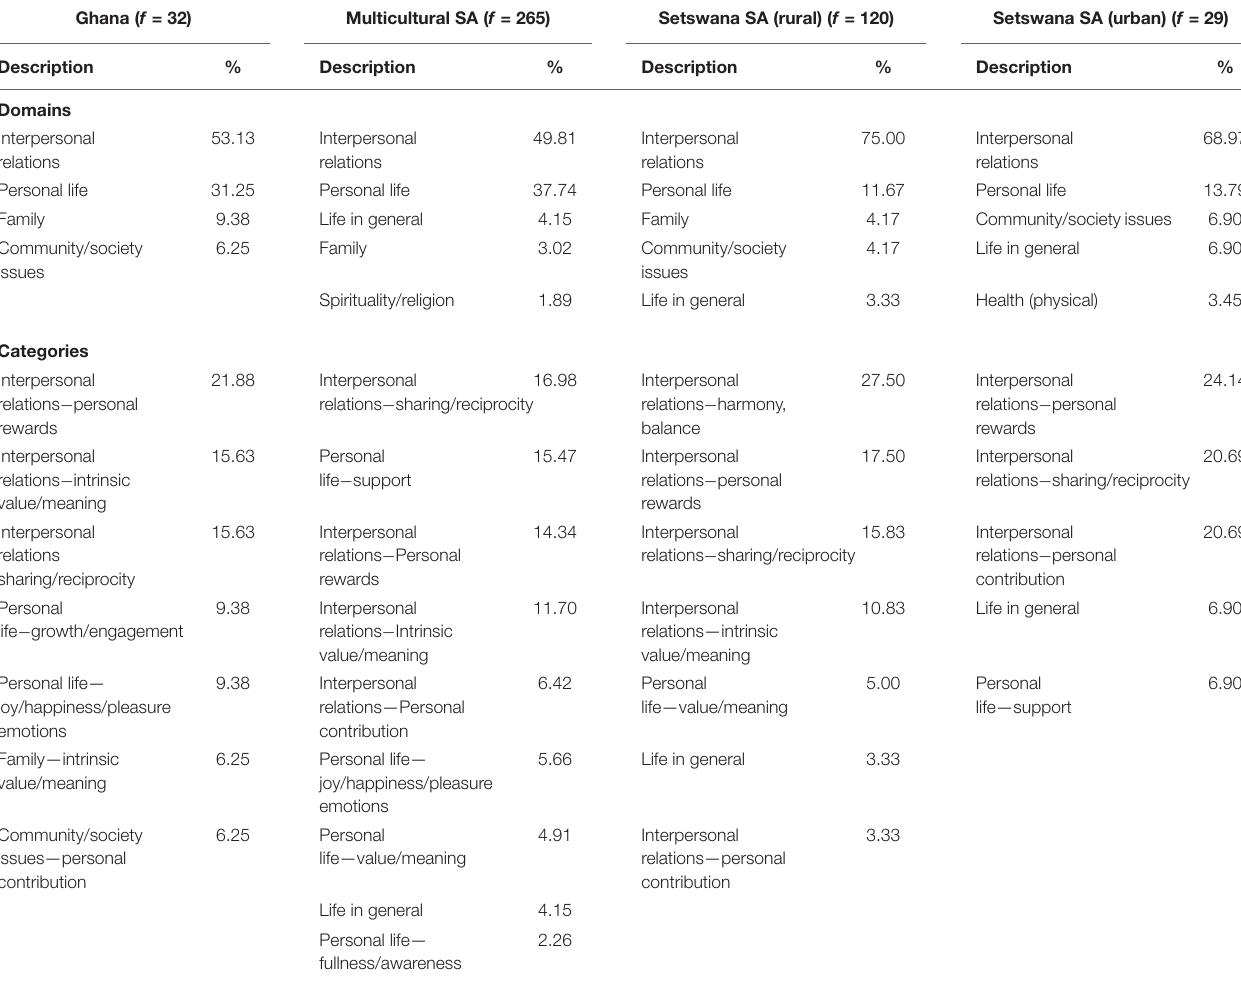
TABLE 5 | Percentages of the most frequent domains and categories in the motivations for meaning sources in the interpersonal relations domain of life. Ghana ( f = 32) Multicultural SA ( f = 265) Setswana SA (rural) ( f = 120) Setswana SA (urban) ( f =